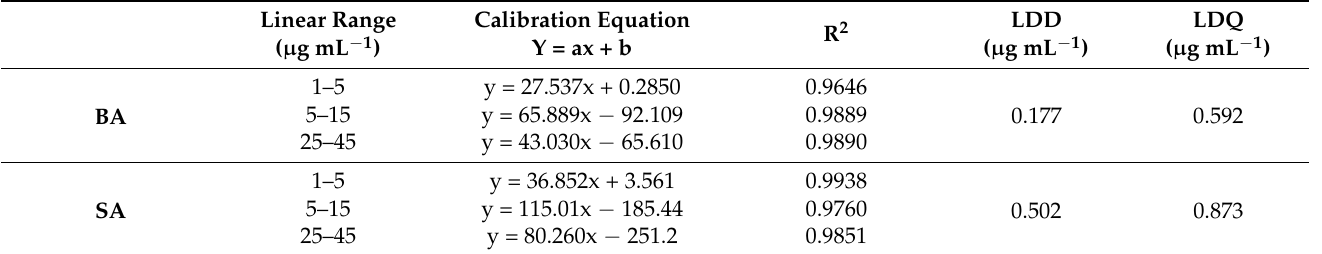
Table 8. Calibration equation, correlation coefficient, and detection and quantification limits of benzoic and sorbic